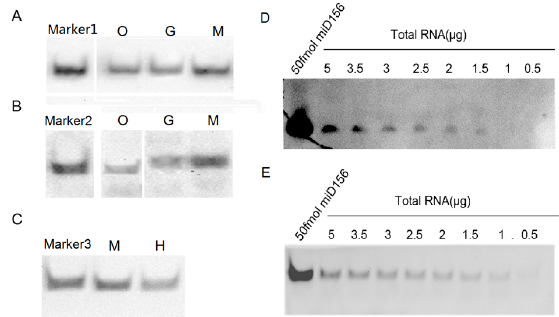
Figure 5. Detection of microRNAs (miRNAs) with LHSPD. ( A ) Detection by biotin-CDP Star system using 1 μ g small RNA samples. Marker1: 50 fmol of miD156 /( Biotin )- miD156rk hybrid; O: Oryza sativa small RNA plus 0.1 pmol ( Biotin ) -miD156rk ; G: Gallus domesticus small RNA plus 0.1 pmol ( Biotin ) -let-7rk ; M: Mus musculus small RNA plus 0.1 pmol ( Biotin ) -let-7rk ; ( B ) Detection by DIG-CDP Star system using 5 μ g small RNA samples. Marker2: 50 fmol of let-7a /( DIG ) -let-7rk hybrid; O: Oryza sativa small RNA plus 0.1 pmol ( DIG ) -miD156rk ; G: Gallus domesticus small RNA plus 0.1 pmol of ( DIG )- let-7rk ; M: Mus musculus small RNA plus 0.1 pmol of ( DIG ) -let-7rk ; ( C ) Detection by biotin-luminol system using 5 μ g small RNA samples. Marker3: 50 fmol of let-7a /( Biotin ) -let-7rk hybrid; M: Mus musculus small RNA plus 0.1 pmol ( Biotin )- let-7rk ; H: Human blood small RNA plus 0.1 pmol ( Biotin ) -let-7rk ; ( D ) Detection of miR156 from Nicotiana tabacum total RNA samples by traditional Northern hybridization with biotin-CDP Star system: 50 fmol of miD156 as a control and different amounts of Nicotiana tabacum total RNA hybridized with 0.1 pmol ( Biotin ) -miD156rk ; ( E ) Detection of miR156 from Nicotiana tabacum total RNA samples by the LHSPD strategy with biotin-CDP Star system: 50 fmol of miD156 as a control and different amounts of Nicotiana tabacum total RNA hybridized with 0.1 pmol ( Biotin ) -miD156rk.